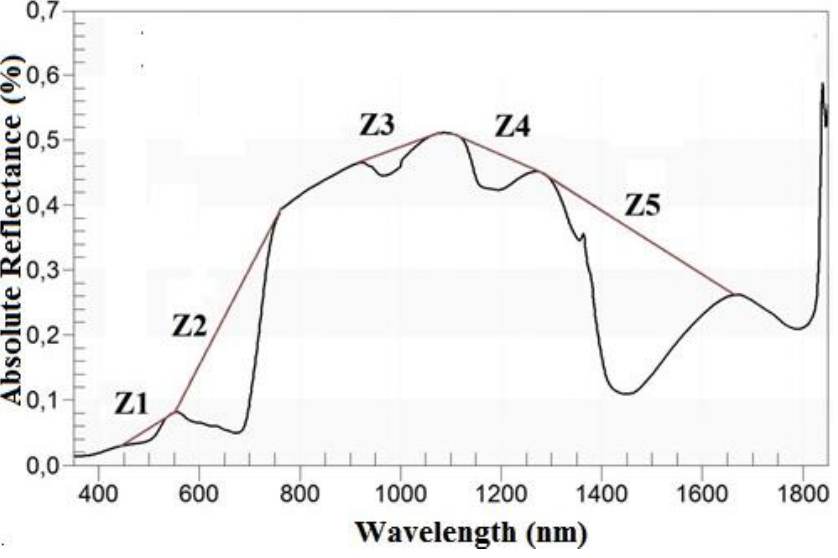
Figure 3. A grass reflectance spectrum and the representation of its continuum and absorption features (Zi: Zone I, as defined in Table